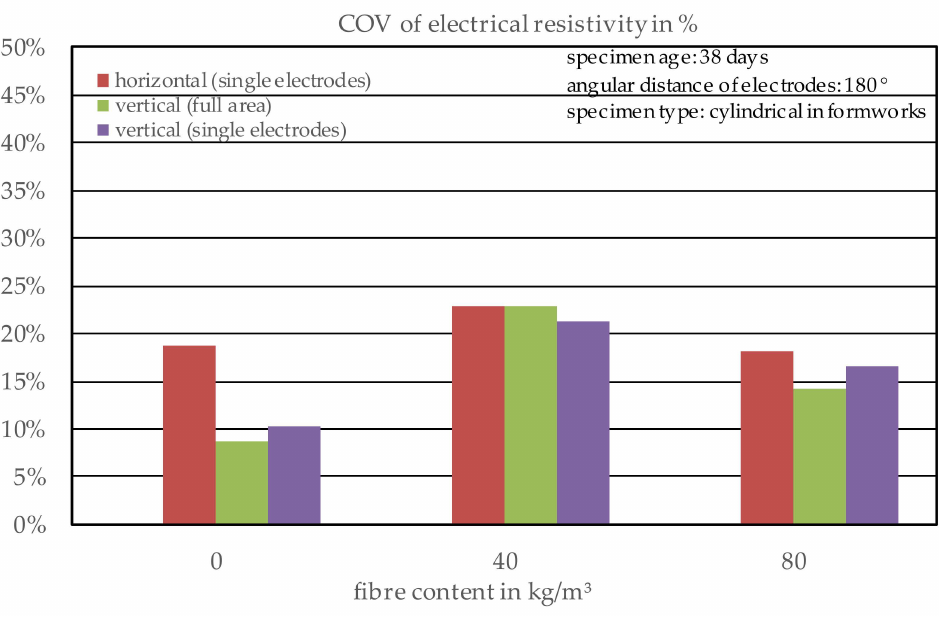
Figure A4. Coefficient of variation of the electrical resistivity in different directions depending on the fibre content at a specimen age of 38 days and an electrode array with angular distances of 180 ◦